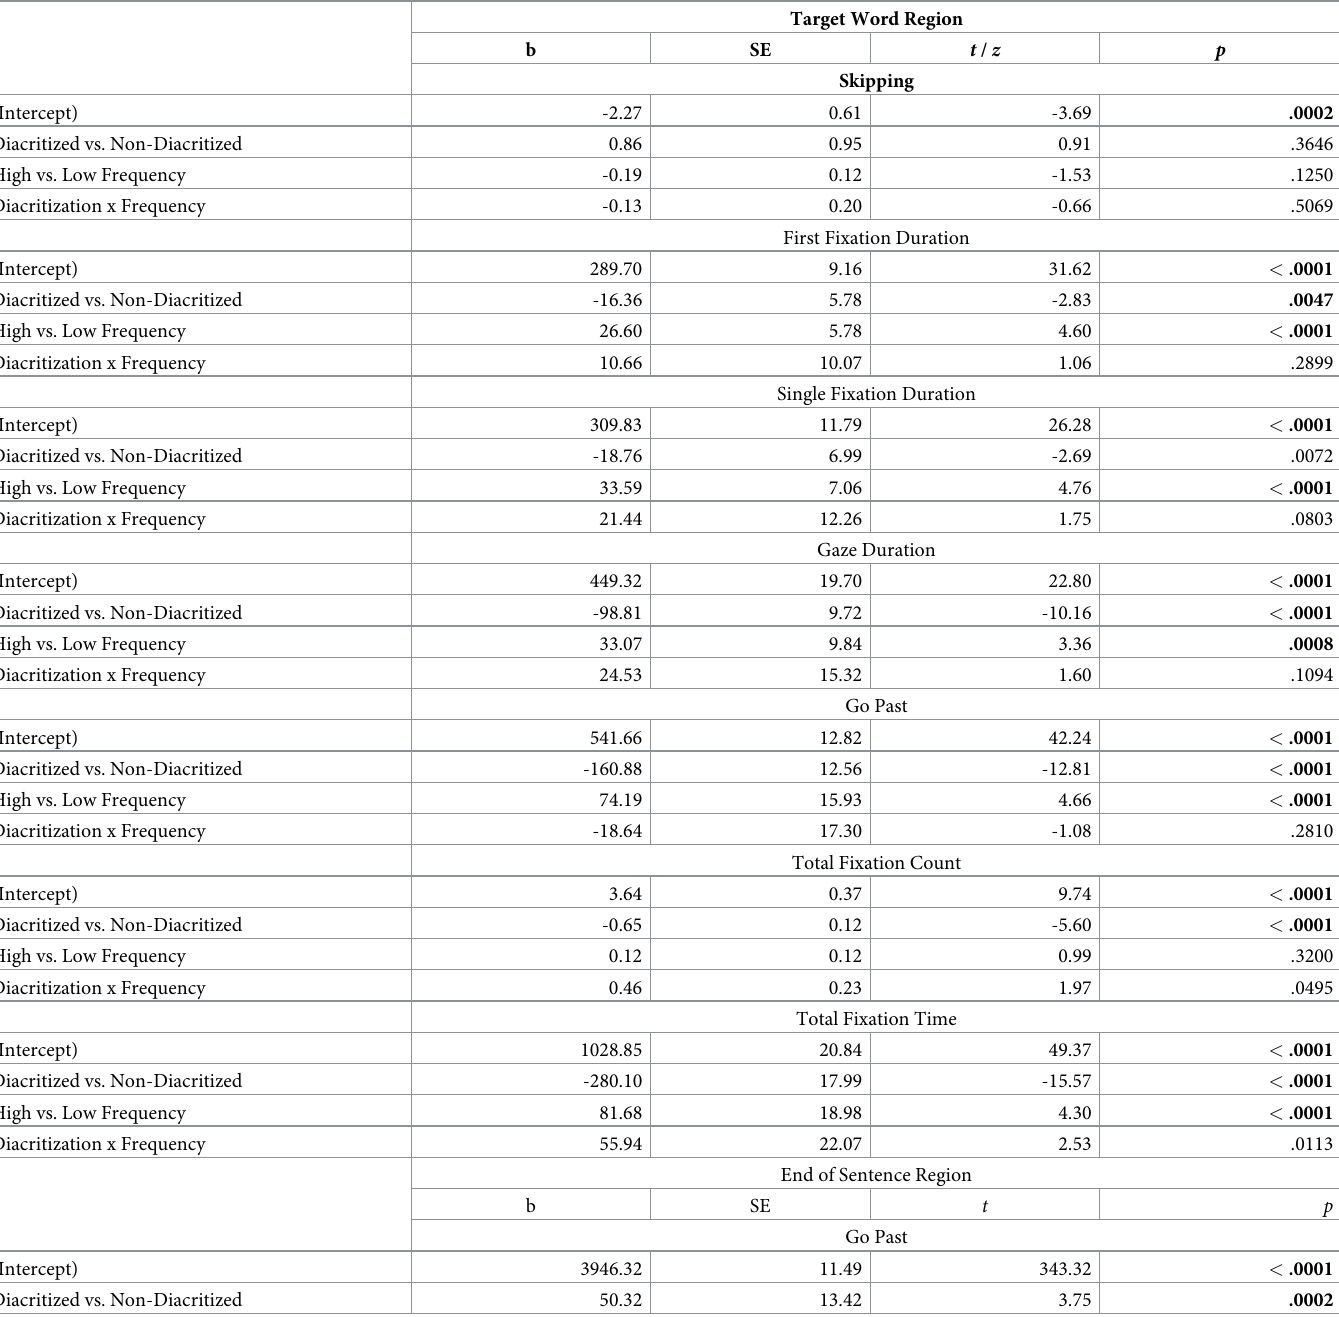
Table 2. GLMM output for eye movement measures (Experiment